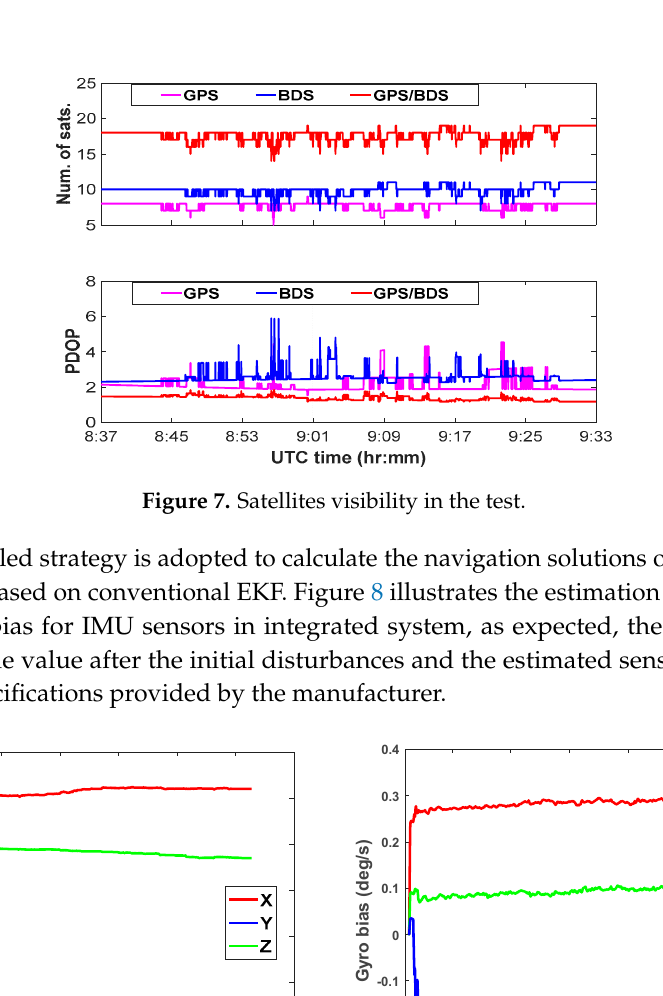
Figure 6. Satellites visibility in the test.